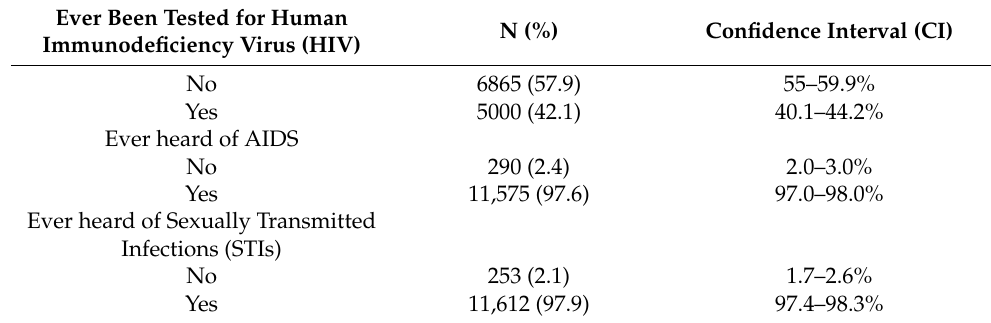
Table 1. Prevalence of Human Immunodeficiency Virus (HIV) Testing among reproductive women aged 15–49 years in the Gambia, (N = 11,865).